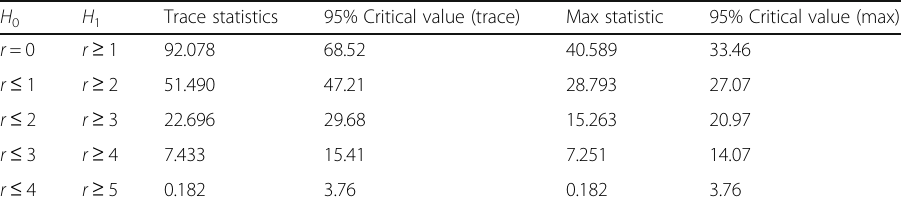
Table 3 Cointegration test results (with